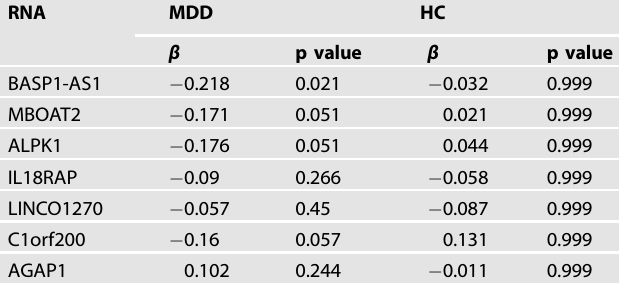
Table 3. Association between RNA expression and right hippocampal tail volumes in MDD and HC groups.